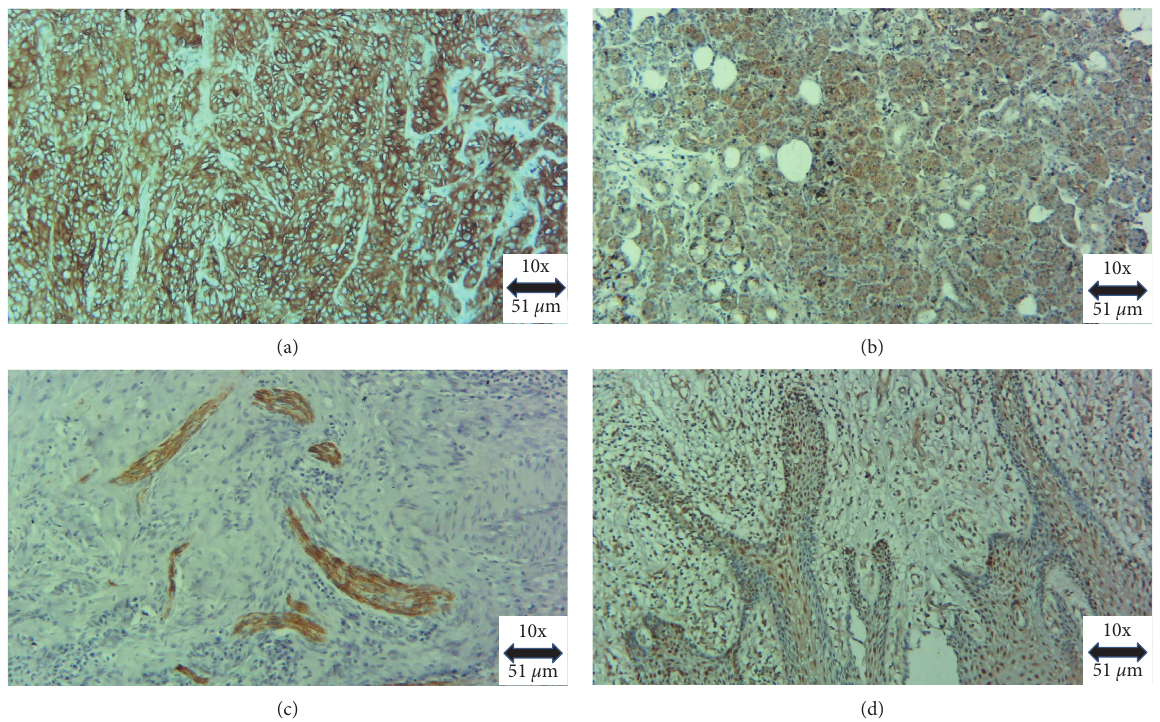
Figure 1: Photomicrograph of (a) CD44 cell membranous positivity, (b) CD133cell membranous and cytoplasmic positivity, (c) L1CAM cell membranous positivity, and (d) SOX2 nuclear positivity in OSCC (magnification × 10).